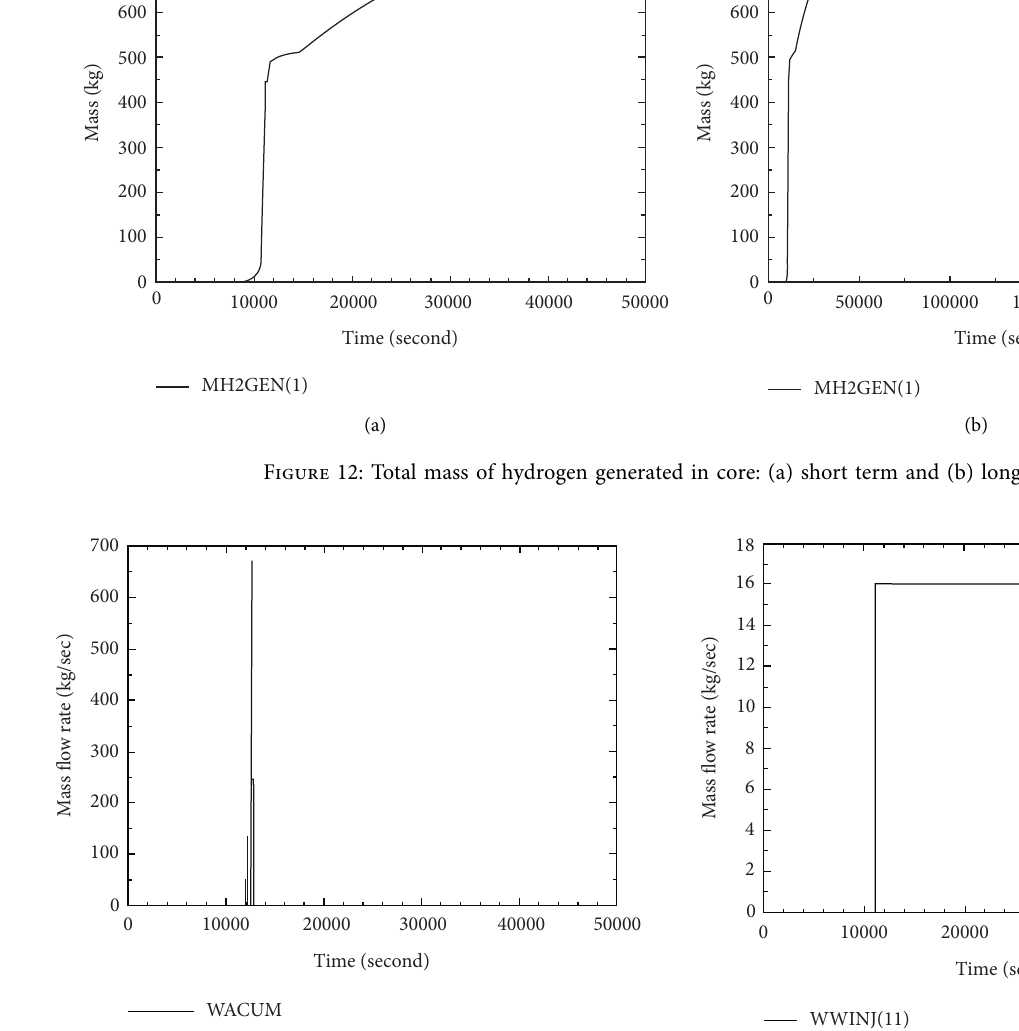
Figure 13: Accumulator mass flow rate. Figure